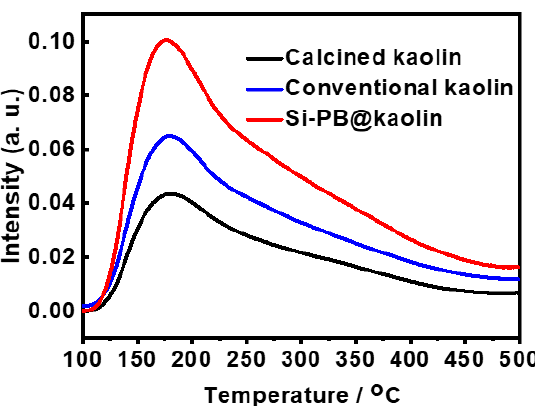
Figure 3. NH 3 -TPD profiles for conventional kaolin, calcined kaolin and Si-PB@kaolin composite.